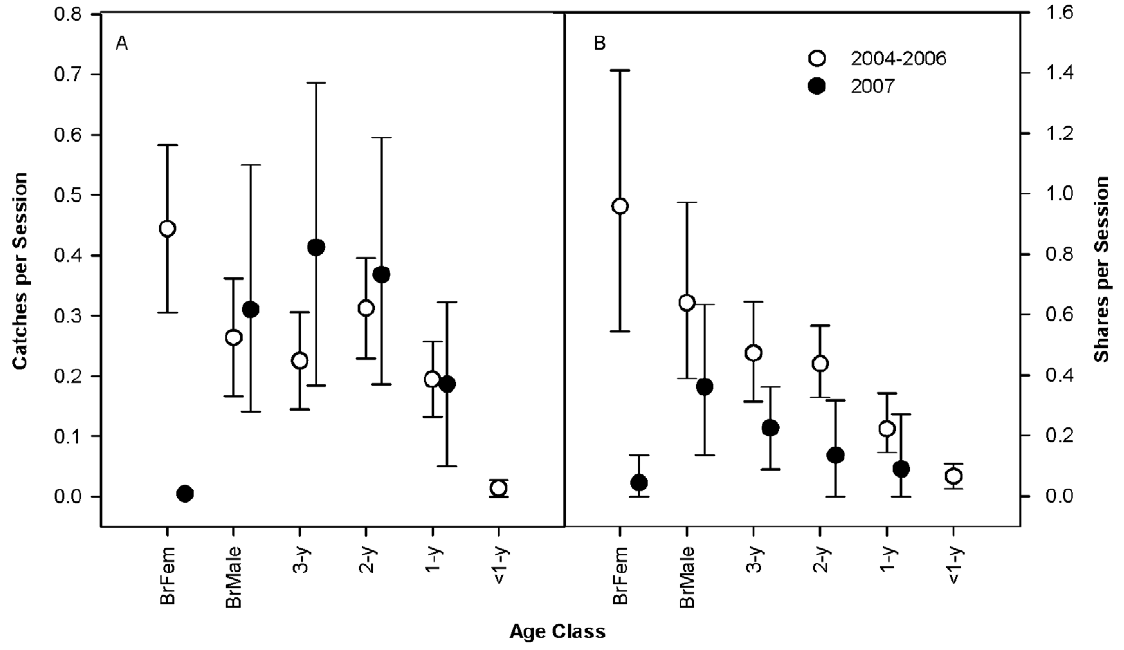
Figure 1. Bootstrapped mean and 95% confidence intervals on average counts per 3-h session by age class of A) catches of large ( $ 30 cm) fish; and, B) prey sharing (prey of all sizes), comparing 2004–2006 vs. 2007 observations. Data represent 15 animals, including 12 juveniles and 3 breeding adults. The age class ‘‘BrFem’’ denotes data on the breeding female, Cacao. No cubs , 1 y were present in 2007.